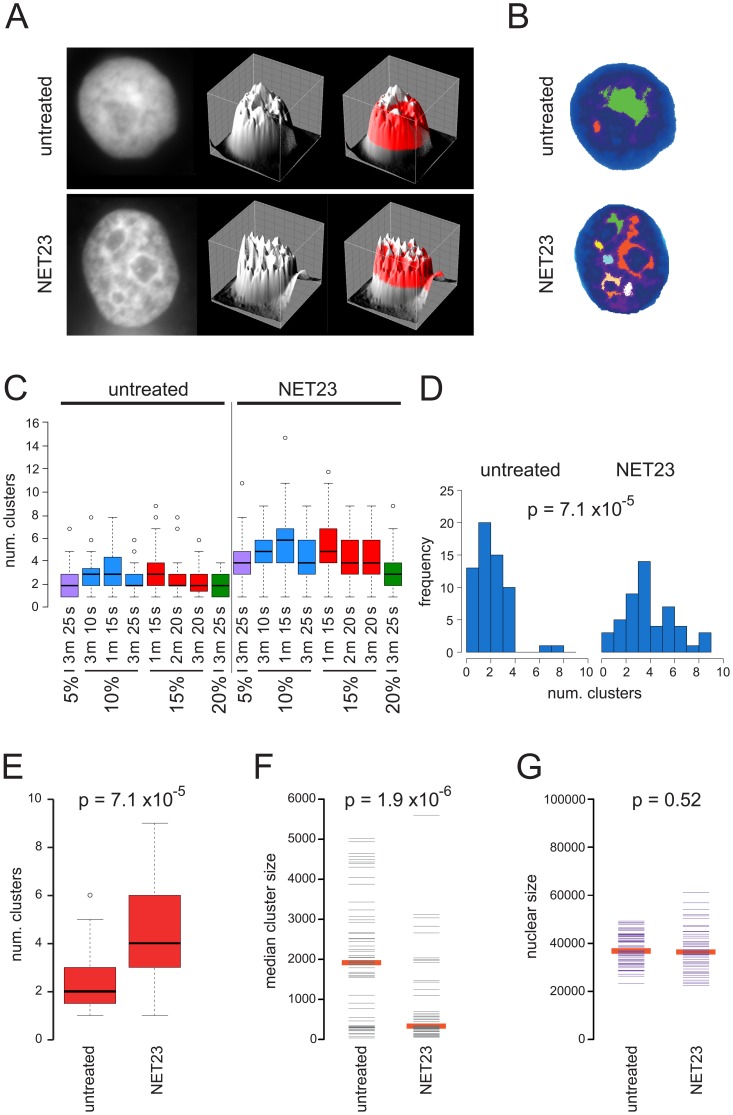
An algorithm for measuring chromatin compaction.(A) Pixel intensities from images obtained using identical microscope and camera settings were plotted topographically. A plane slicing through the topographic map at a particular percentage of the total intensity reveals only a small number of high intensity pixel clusters for untransfected cells while several high intensity pixel clusters can be observed for NET23/STING transfected cells. (B) Each high intensity pixel cluster for a particular plane in the cells shown in A is color-coded to visualize how accurately the algorithm distinguishes individual clusters. In setting the algorithm this step was used to optimize the parameters for numbers of pixels between clusters that would result in a merging of the clusters. (C) Several different parameterizations are able to distinguish between untransfected and NET23/STING transfected cells. A range of pixel intensity cutoffs for the plane are tested from 5–20% total pixel intensity (%). Also the number of pixels connecting clusters before merging them (m) and the minimum cluster size in pixels (s) were varied. This confirmed that the algorithm is robust and unbiased as statistically significant differences between the untransfected and NET23/STING transfected cells could be observed for nearly all parameters tested. (D) Histogram showing the shift in the distribution of the number of clusters between untransfected and NET23/STING transfected cells at the final parameters chosen: 15% signal intensities, 20 pixel minimum cluster size, and 3 connecting pixels required for merging. (E) Box and whiskers plot showing the distribution for the data in D and p-value calculated using a Kolmogorov-Smirnov (KS) test. (F) The same parameterization with plotting instead the cluster size medians. A similarly strong difference is observed with p-value calculated using a KS test. (G) Nuclear size was also measured for the cells analyzed and found to not change between the untransfected and NET23/STING transfected cell populations.